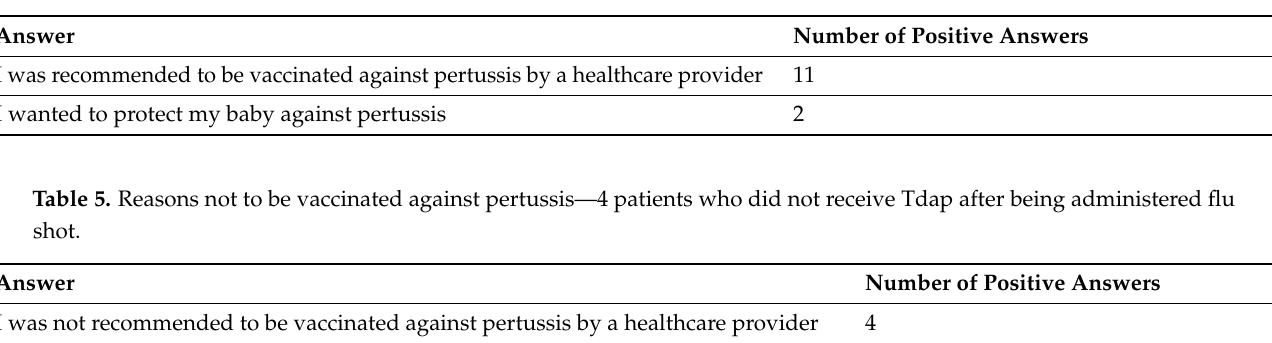
Table 4. Main reason to be vaccinated against pertussis—13 patients who accepted both flu and Tdap vaccines.